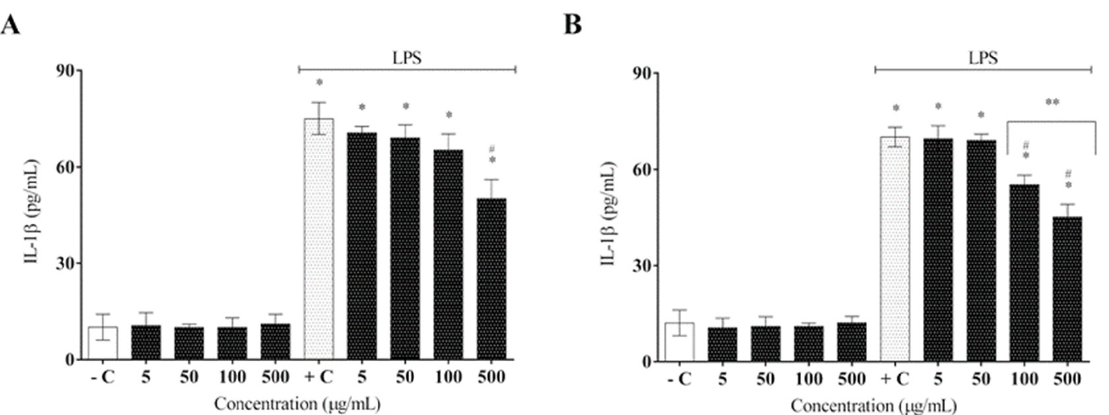
Figure 5. Effect of L. rigida extracts on IL-1 β cytokine release: ( A ) AELR and ( B ) HELR. The cytokine content was released in RAW 264.7 cells and stimulated by LPS after 24 h. Release of cytokines was quantified by ELISA analysis. Data represent the mean ± SEM from three independent experiments. One-way ANOVA was used followed by a post hoc Tukey test. * p < 0.05 vs. the negative control group; # p < 0.05 vs. the LPS-stimulated cells; ** p < 0.05 between extract concentrations.